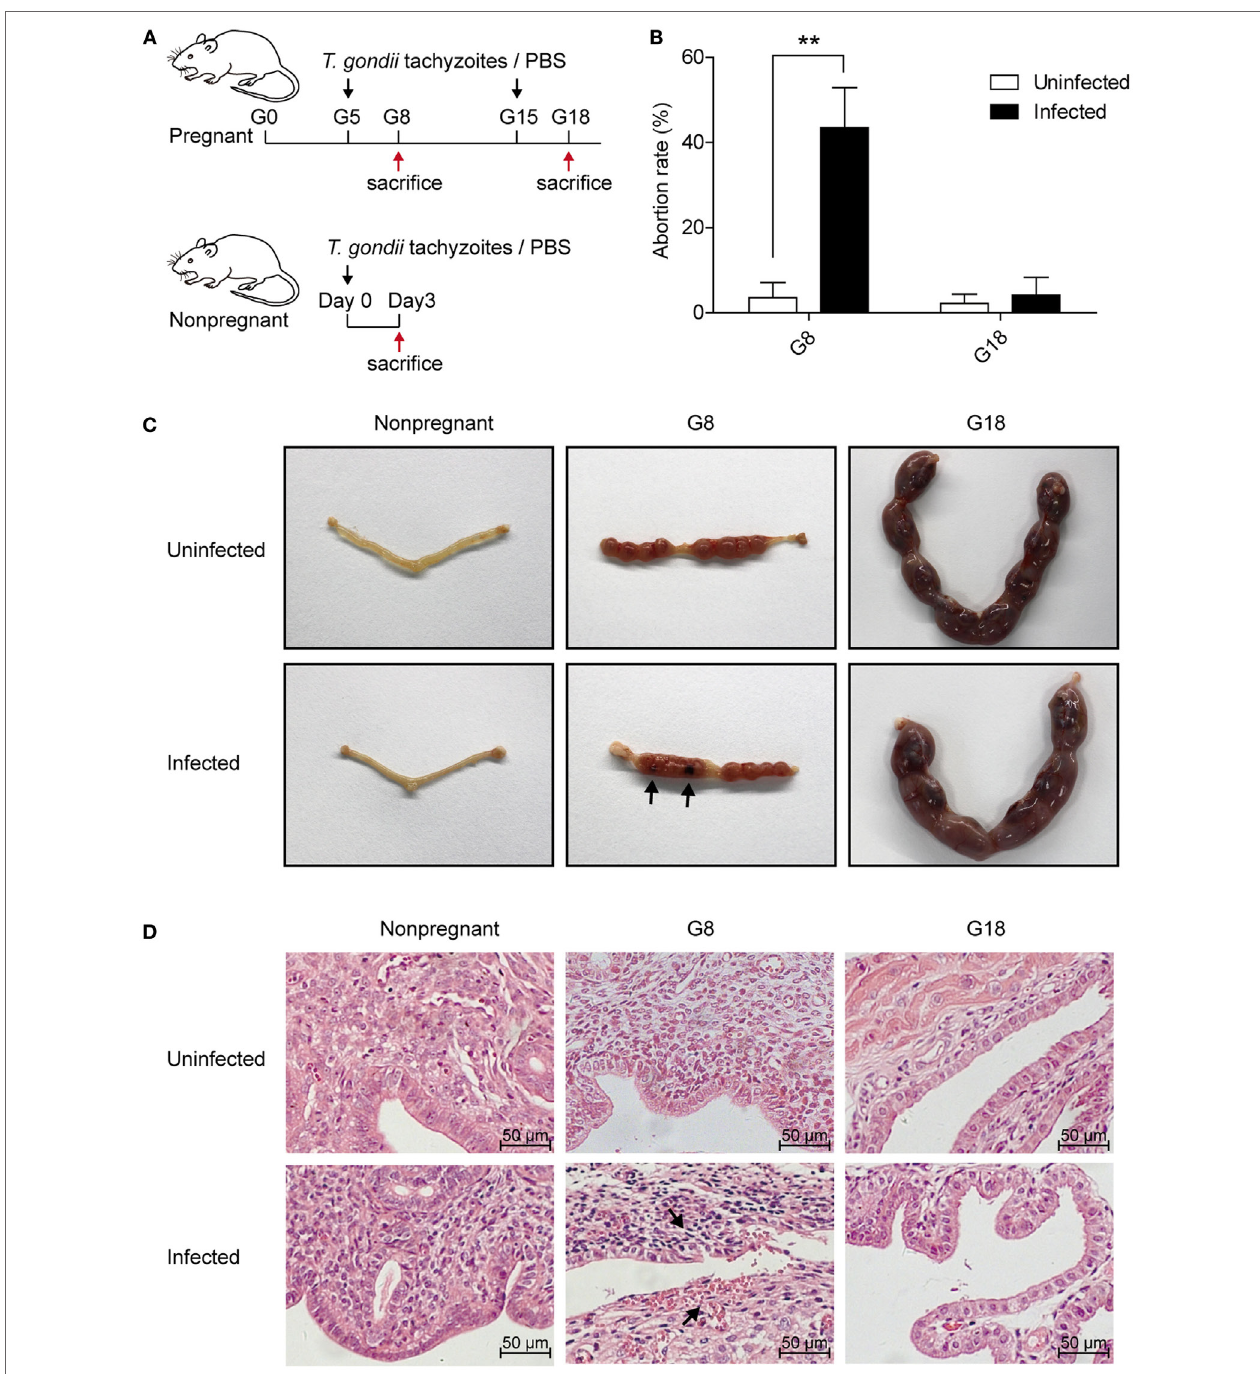
FigUre 1 | The discrepancy of pregnancy outcomes in mice infected with Toxoplasma gondii tachyzoites at different stages of pregnancy. (a) Time schedule for T. gondii infection. Nonpregnant and pregnant mice at gestational days 5 (G5) and 15 (G15) were injected with T. gondii tachyzoites or PBS, respectively. All the animals were sacrificed at 3 days post infection (nonpregnant, G8 and G18). (B) The abortion rates of pregnant mice at gestational days 8 (G8) and 18 (G18) with T. gondii tachyzoite or PBS injection. The abortion rate was calculated as the ratio of abortion sites to the total number of implantation sites. Data are expressed as the means ± SD of five mice for each group from one experiment representative of three independent experiments. ** P < 0.01. (c) Representative pictures of uteri from nonpregnant and pregnant mice at G8 and G18 with T. gondii tachyzoite or PBS injection. Fetuses and placentas of early pregnant mice (G8) suffered necrosis and hemorrhage after T. gondii infection (black arrow), while late pregnant mice (G18) did not exhibit any adverse pregnancy outcomes after infection. (D) Representative histopathological sections with H&E staining of the maternal–fetal interface from mice as mentioned above. The maternal–fetal interface of early pregnant mice (G8) displayed obvious hemorrhage and inflammation with T. gondii infection at G5 (black arrow), while pregnant mice (G18) with infection at G15 did not exhibit any adverse pregnancy outcomes. Scale bars, 50 µm.